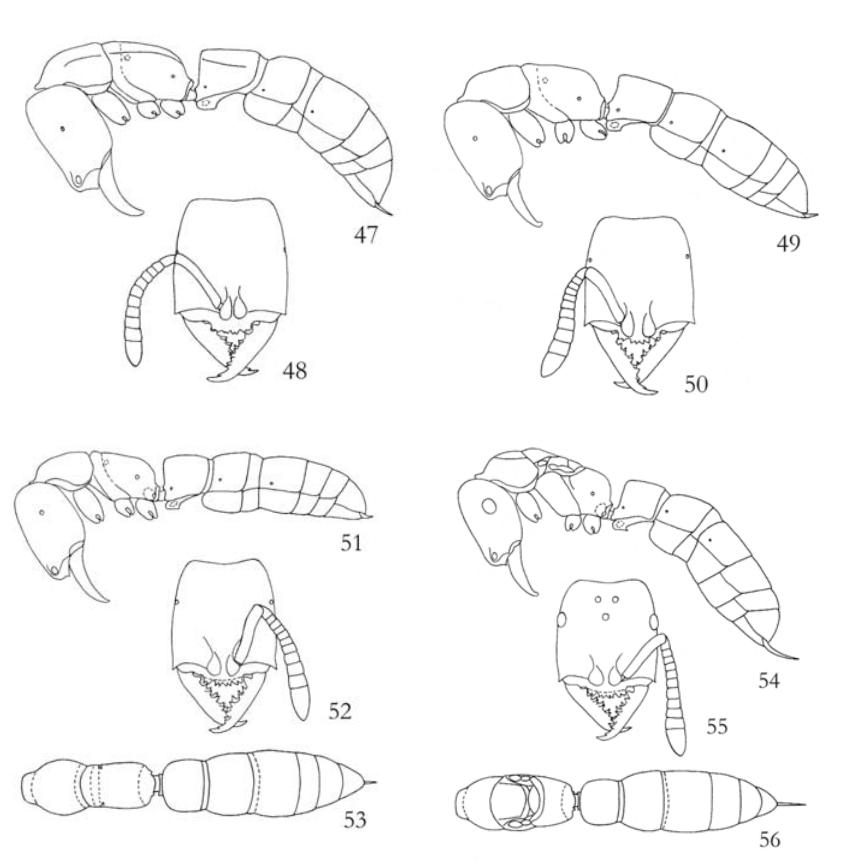
Figs. 47-56. 47-48: Worker of Amblyopone luzonica (Wheeler et Chapman); 47. Head and body in profile view; 48. Head in full-face view. (Drawn from Antweb images). 49-50: Worker of Amblyopone silvestrii (Wheeler); 49. Head and body in profile view; 50. Head in full-face view. (Drawn from Antweb images). 51-53: Worker of Amblyopone awa sp. nov.; 51. Head and body in profile view; 52. Head in full-face view; 53. Body in dorsal view. 54-56: Queen of Amblyopone awa sp. nov.; 54. Head and body in profile view; 55. Head in full-face view; 56. Body in dorsal